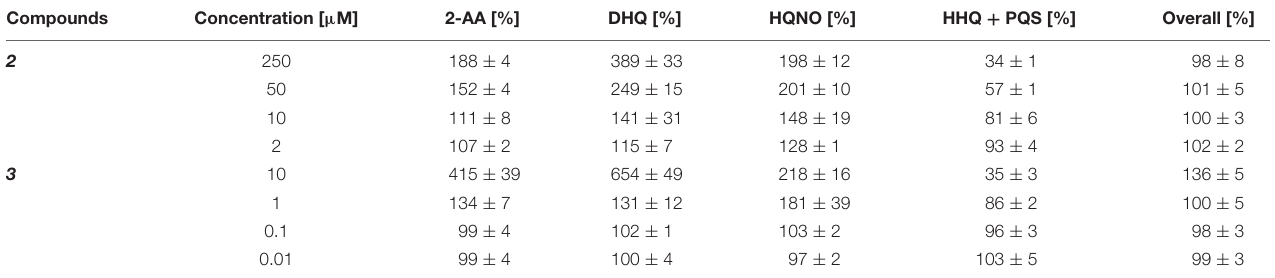
TABLE 3 | Production of pqs signal molecules in PA14 wt after the treatment with PqsBC inhibitors. Compounds Concentration [ µ M] 2-AA [%]